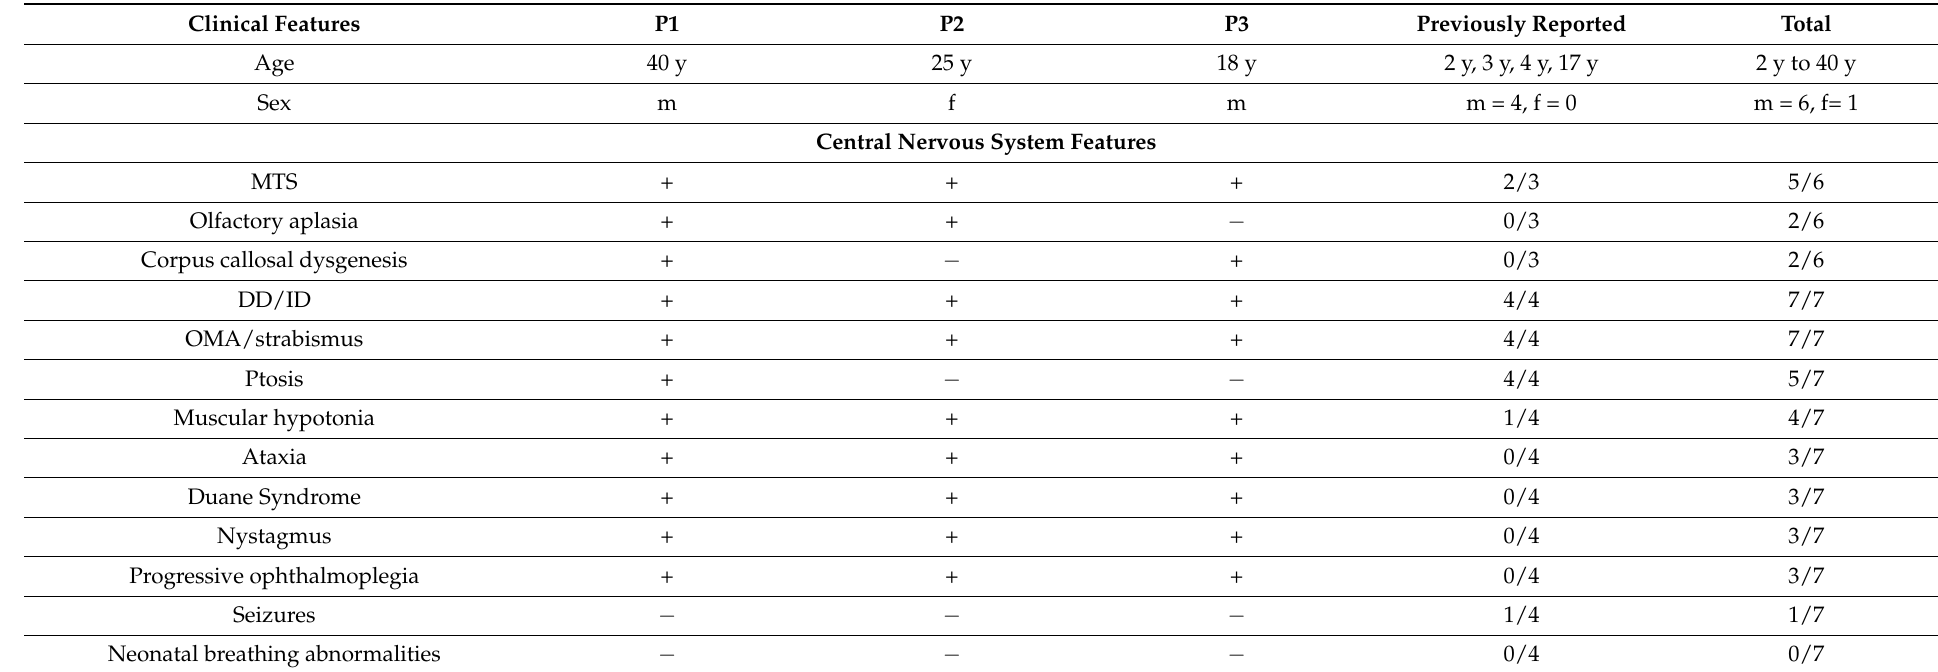
Table 1. Ciliopathy features in seven patients with biallelic truncating FAM149B1